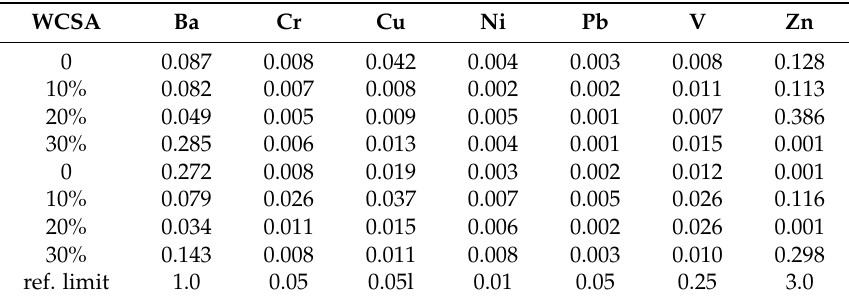
Table 7. Cumulated heavy metals (mg/L) in the leaching solution.